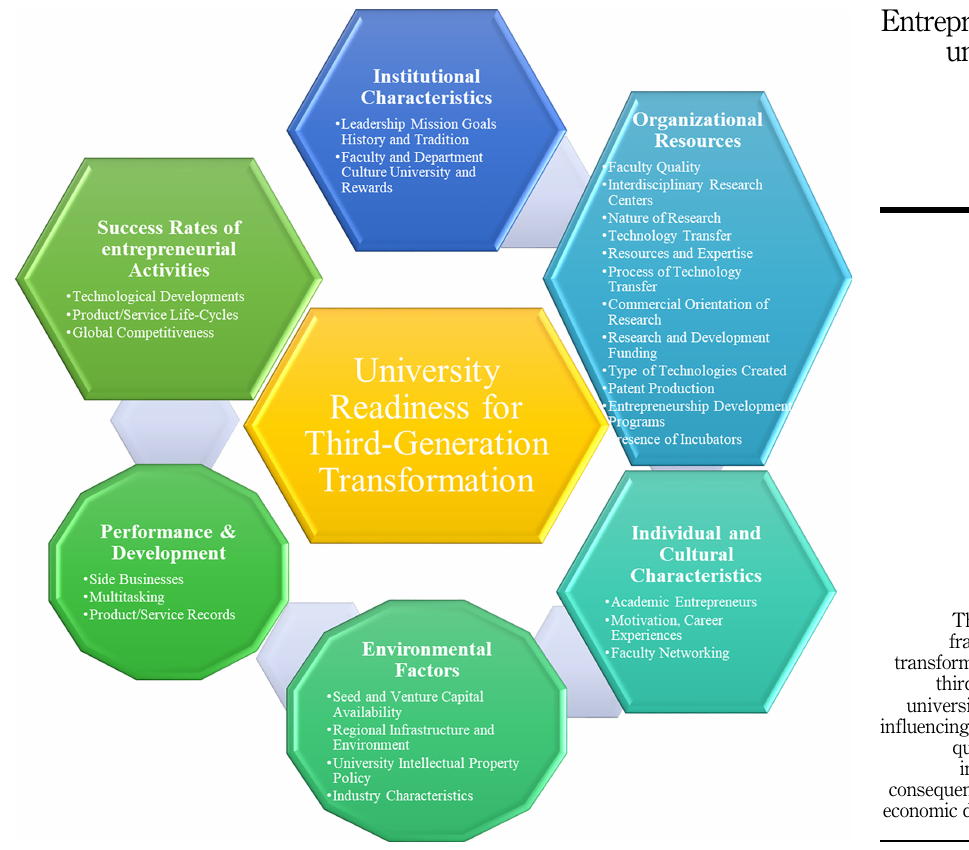
Figure 2. The readiness framework for transformation into a third-generation university based on influencing factors and quantitatively indicating its consequences on local economic